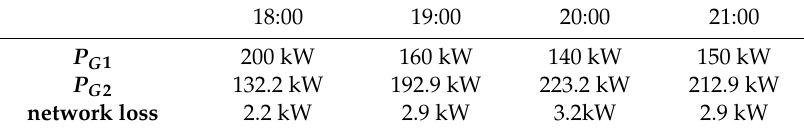
Table 6. Virtual power active output and network loss for